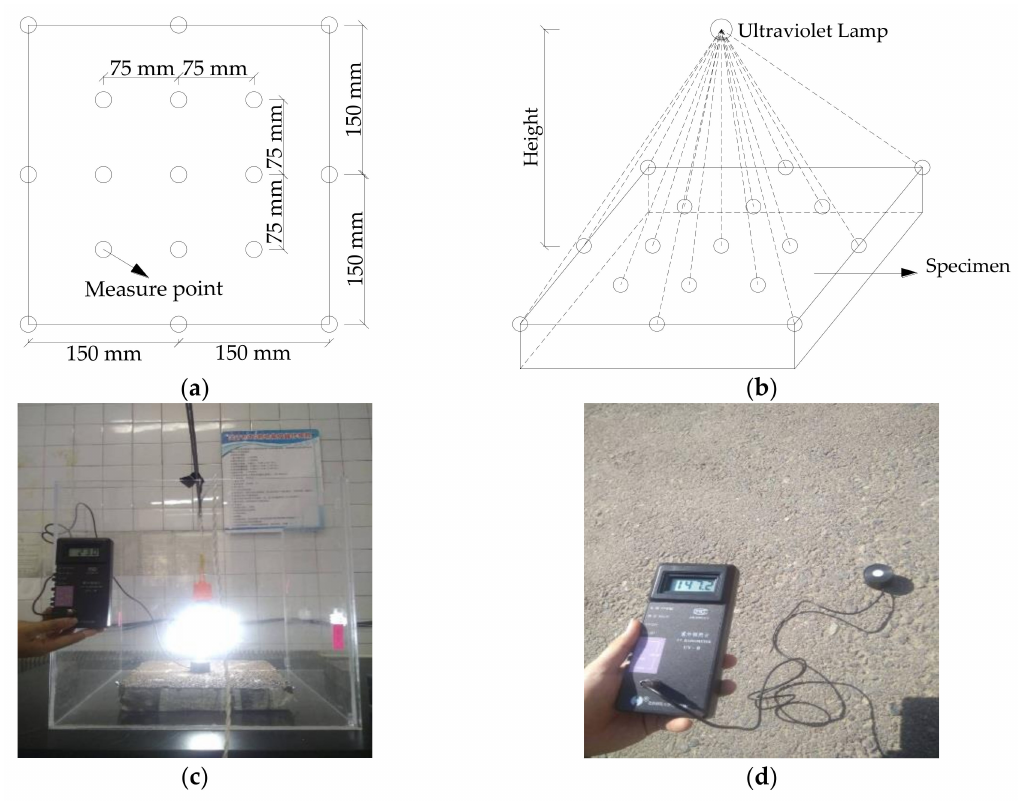
Figure 3. Ultraviolet irradiation intensity experiment of ultraviolet lamp and sunlight: ( a ) measuring point diagram; ( b ) test diagram; ( c ) ultraviolet intensity test; ( d ) sunlight intensity